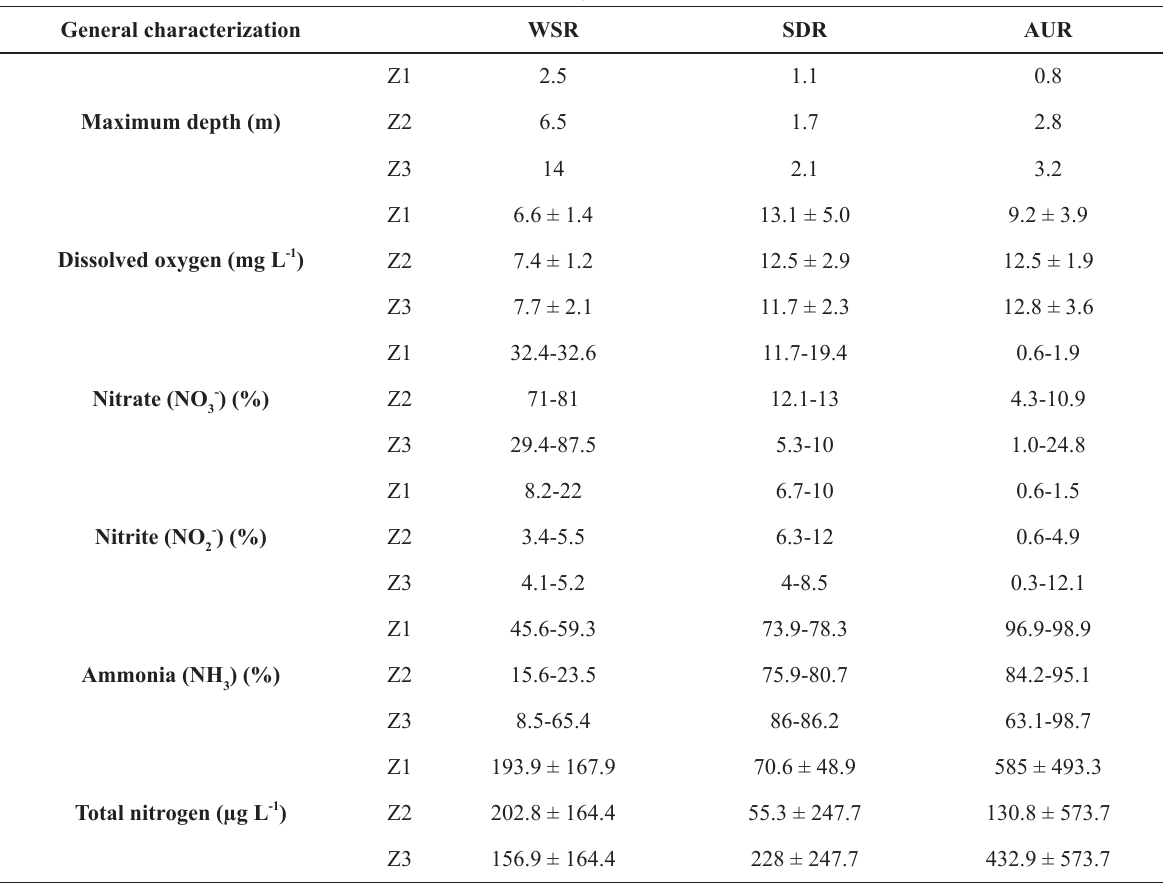
General characterization of the studied reservoirs from the tropical semiarid basin (Pajeú river). Note: Depth refers to the maximum values recorded in the study and not to the maximum overall depth in each reservoir. WSR = water supply reservoir (Cachoeira II); SDR = sewage discharge reservoir (Borborema); AUR = aquaculture-use reservoir (Saco I); Z1 = river zone; Z2 = transition zone; Z3 = lacustrine zone. (mean ± standard deviation) and range (minimum % - maximum %).